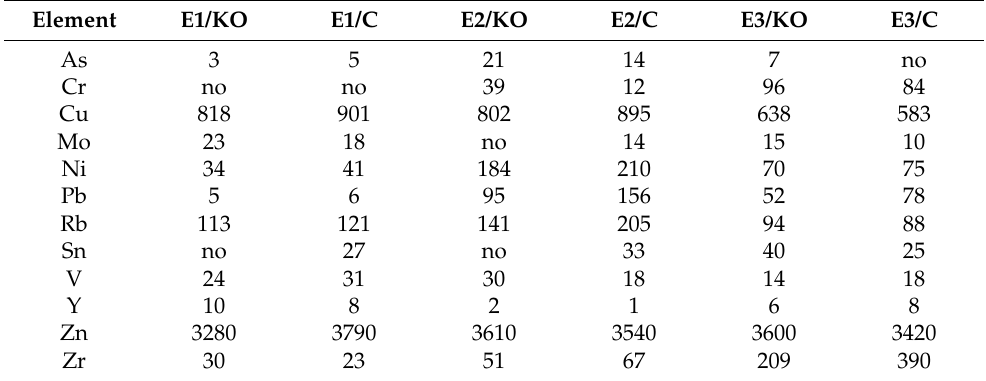
Figure 7. Ternary Bubble Plot in the system MgO + CaO—Others—P 2 O 5 . Annotations: C—ash grain composition of sample E3/C, KO—ash grain composition of sample E3/KO, Pi—theoretical chemical composition of selected phosphorous phases, P1-potassium magnesium phosphate (V), P2-nonacal- cium magnesium sodium heptakis (phosphate (V)), P3-nagelschmidtite, P4-wopmayite. 3.2.2. Phase Composition of Ash X-ray diffraction (XRD) identified the following phase components in all ash samples (Table 7, Figure S4): potassium magnesium phosphate (V), nonacalcium magnesium so- dium heptakis (phosphate (V)), nagelschmidtite, periclase and sylvine. Apatite (except for sample E3/C), wopmayite, arcanite (except for sample E2/KO) and calcite (except for sam-